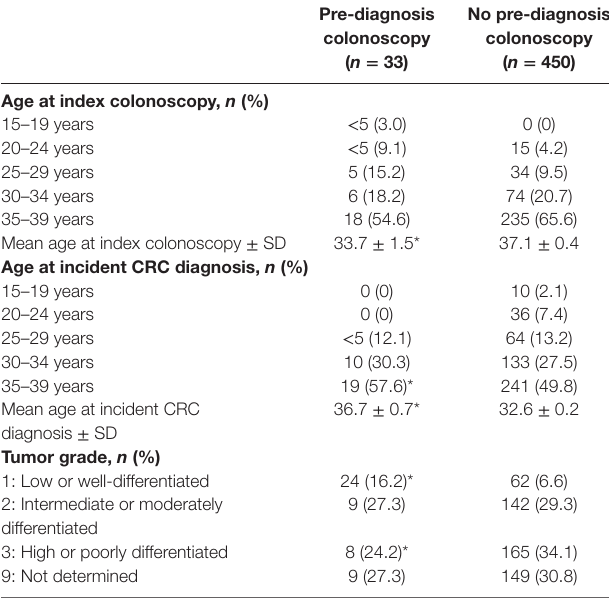
Table 2 | Comparison of age and tumor grade at colorectal cancer (CRC) diagnosis between adolescents and young adults (AYAs) with and without pre- diagnosis colonoscopy ( n = 483).